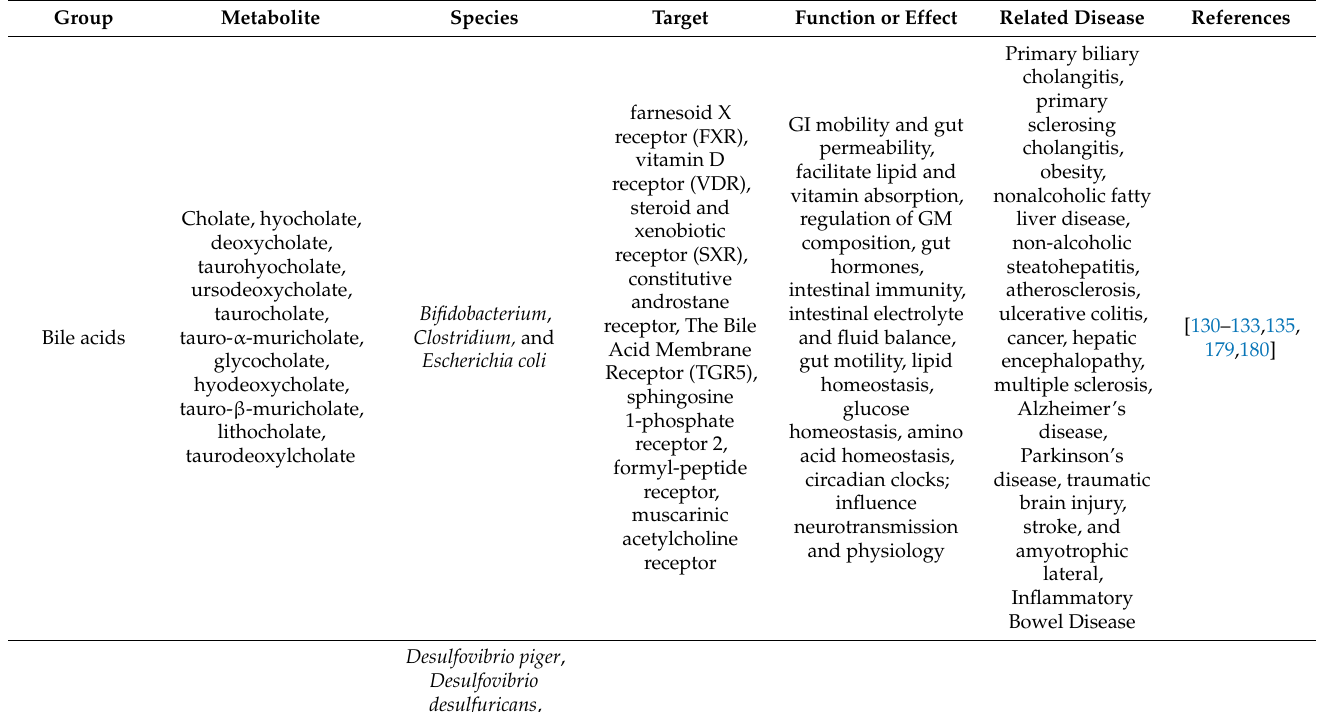
Table 3. Gut microbiota-derived metabolites and their effect on human health and